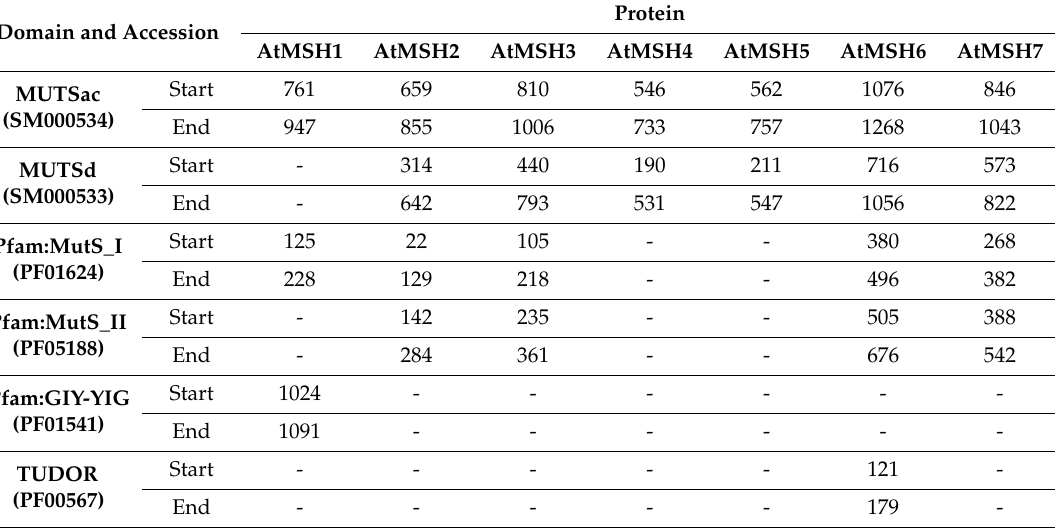
Table 3. Domains of MSH